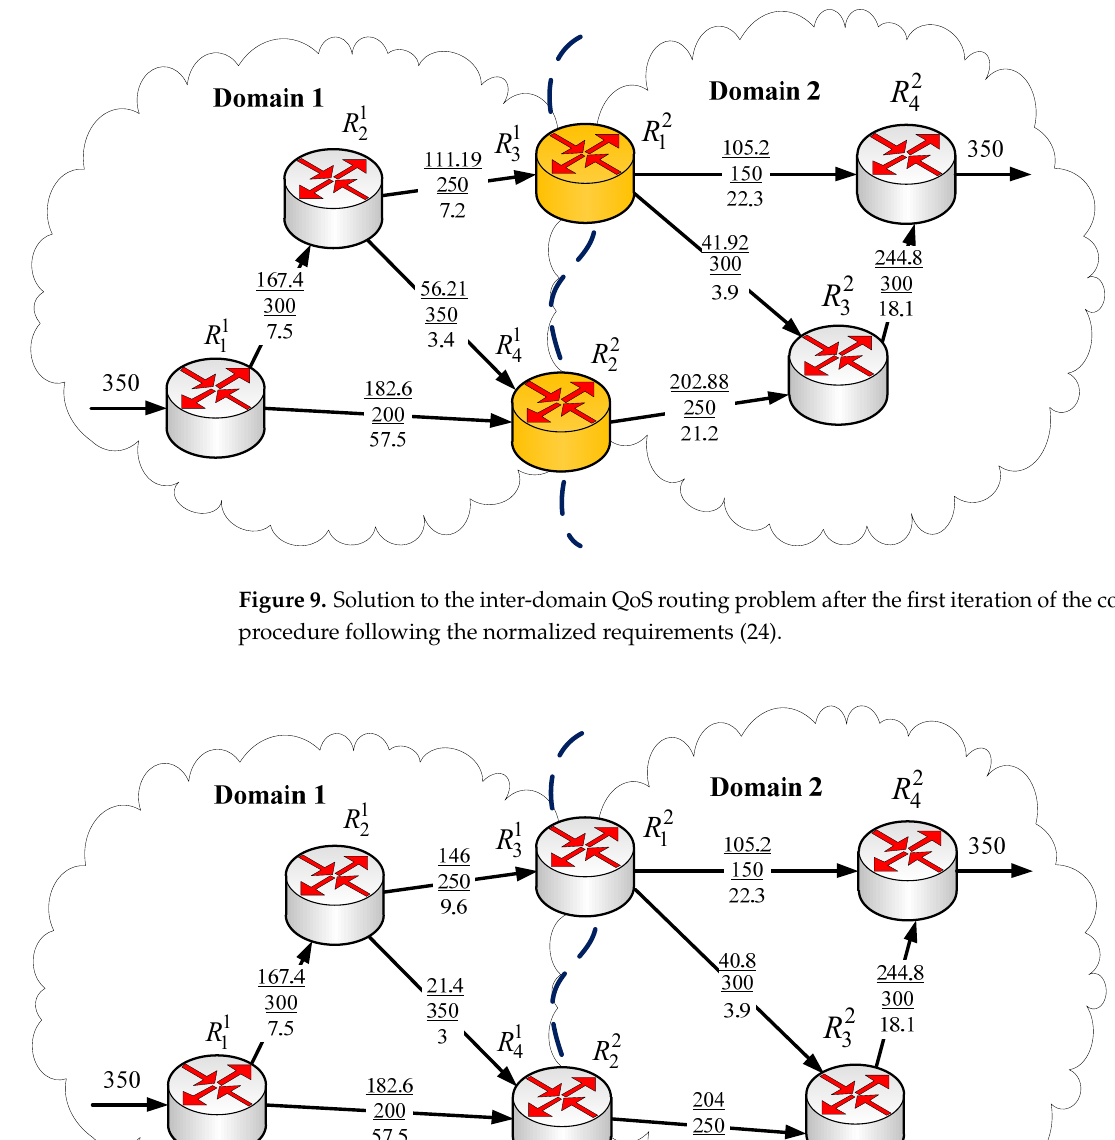
requirements (24).